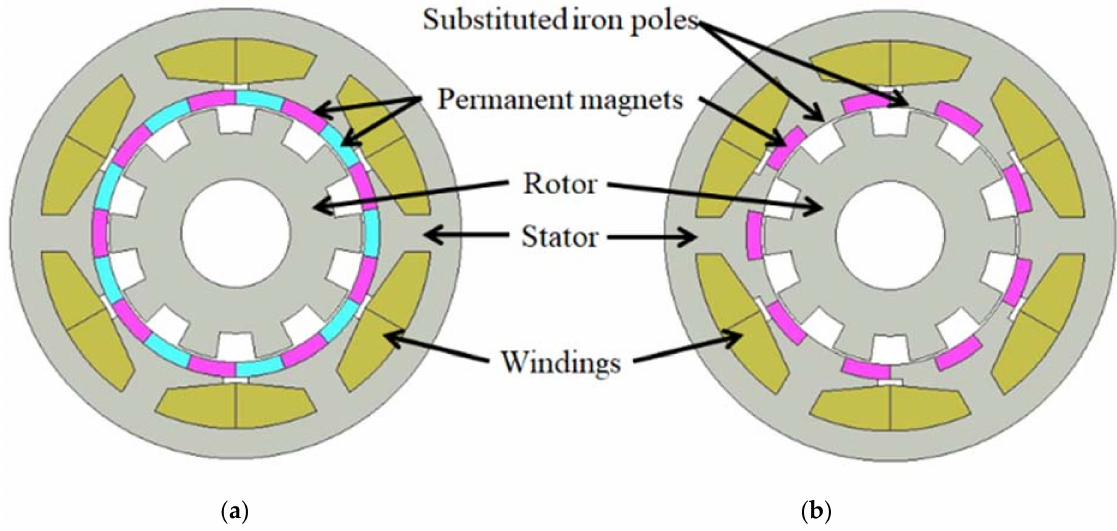
Figure 1. Stator PM Vernier machine: ( a ) conventional machine and ( b ) consequent pole machine. The torque enhancement over the conventional machine by the consequent pole machine is explained. To theoretically demonstrate the torque enhancement principle, torque production is